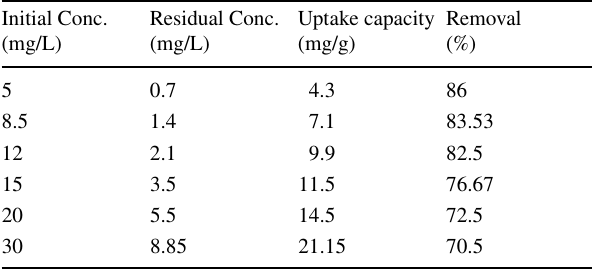
Fig. 6 Removal of Cr(VI) using different doses of ACP – Zn and ACP-Zn-Fe at initial concentration 12 mg/L, pH 2.0—2.5